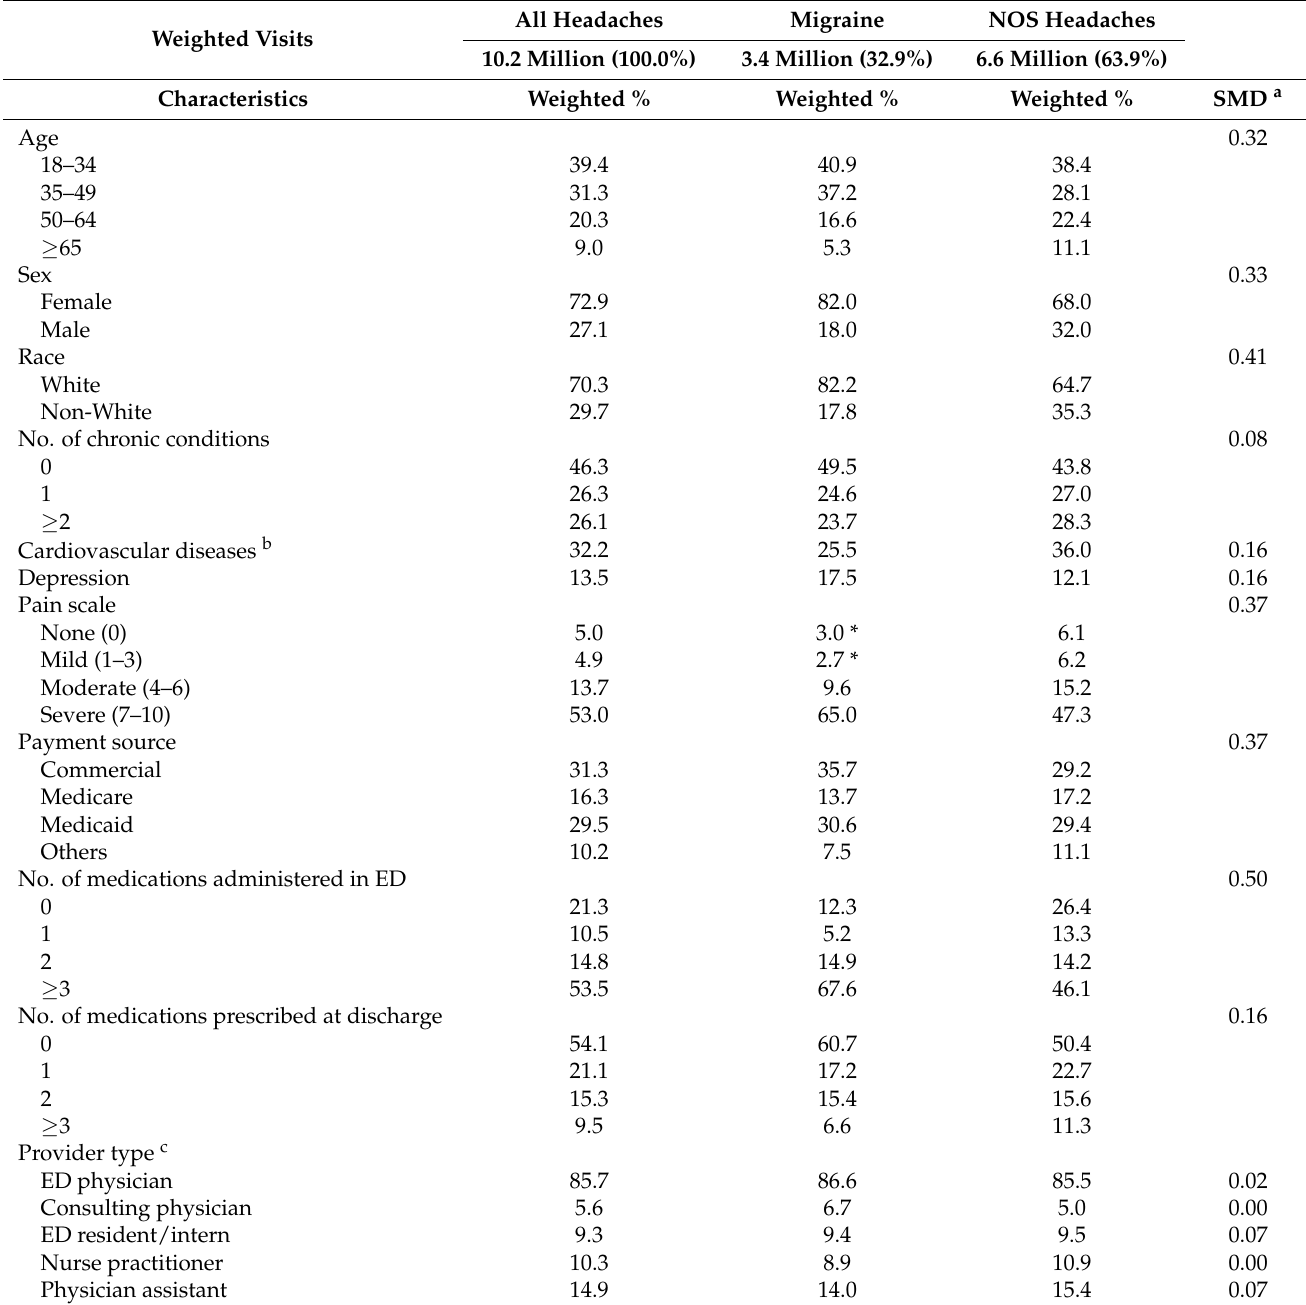
Table 1. Patient characteristics among headache-related ED visits in the US: 2015 to 2018 NHAMCS